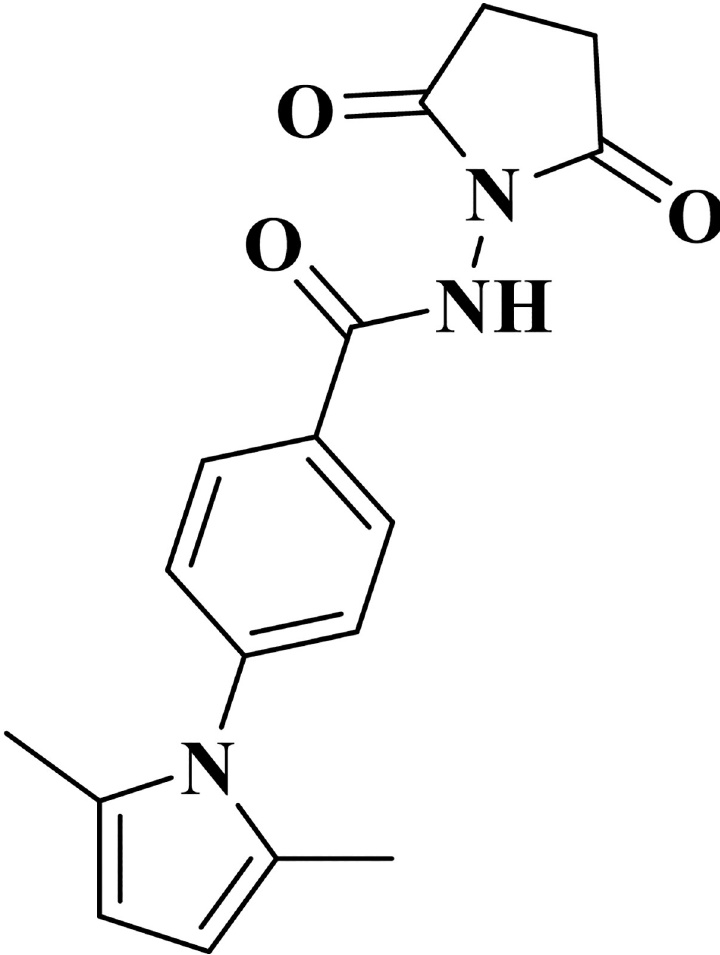
Fig 4. The structure of 4-(2,5-dimethyl-1 H -pyrrol-1-yl)- N -(2,5-dioxopyrrolidin-1-yl) benzamide (MPPB).